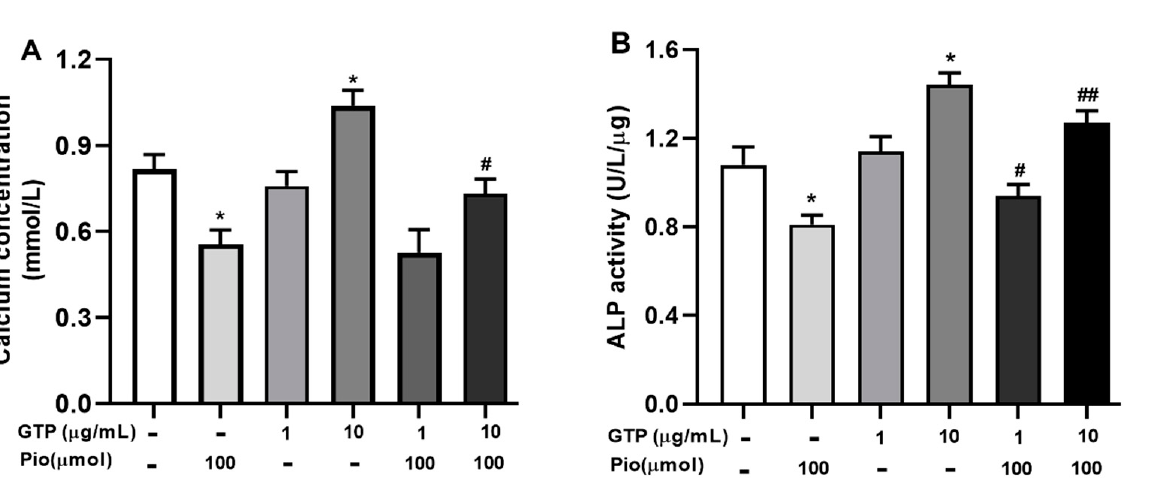
Figure 4. Green tea polyphenols (GTPs) increase calcium content and ALP activity in mature osteocytes. Quantitative assay of calcium level ( A ) and ALP activity ( B ) was performed using an automatic biochemistry instrument (ARCHITECT, Japan). Data from 4 separate experiments are presented as means ± SE. * p < 0.05 pioglitazone and GTPs vs. the control; # p < 0.05 and ## p < 0.01 GTPs